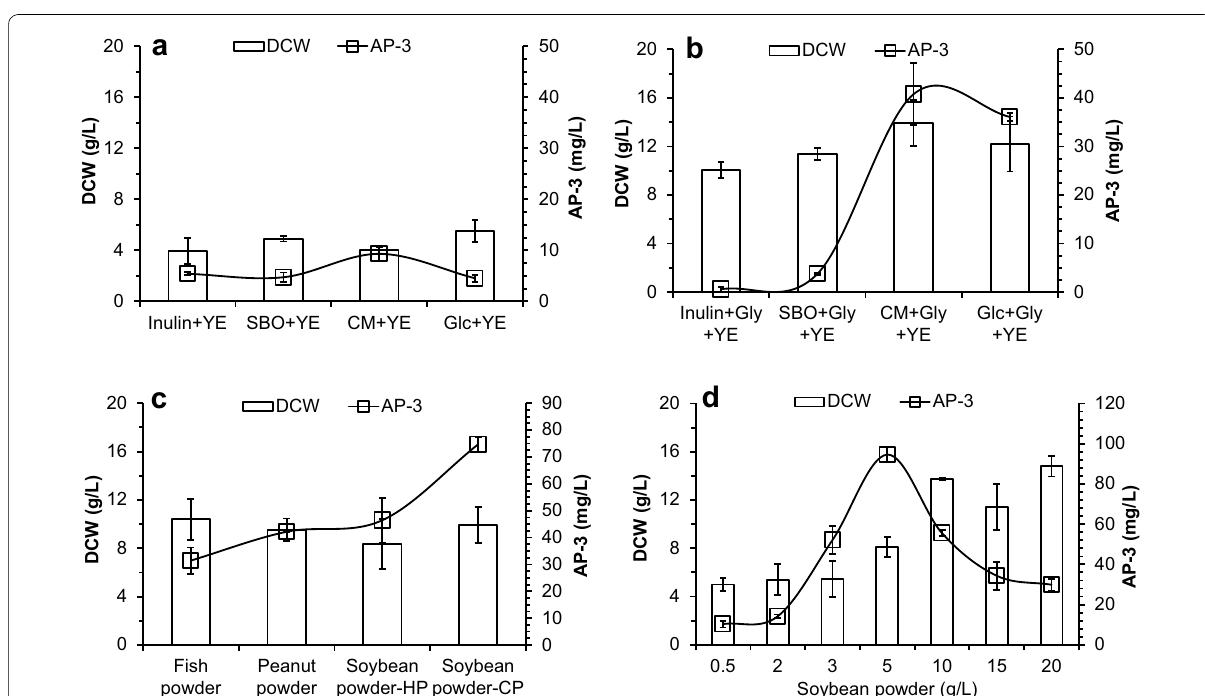
Fig. 1 Effects of various low‑cost carbon and nitrogen sources on AP‑3 fermentation. a Cultures grown on different carbon sources in medium M3. YE yeast extract, CM cane molasses, SBO soybean oil, Glc glucose. b Effects of glycerol on AP‑3 production with medium M4. c Cultures grown on different nitrogen sources in medium M2. Soybean powder‑HP, hot‑pressed soybean powder; Soybean powder‑CP, cold‑pressed soybean powder. d Effects of cold‑pressed soybean powder on AP‑3 accumulation